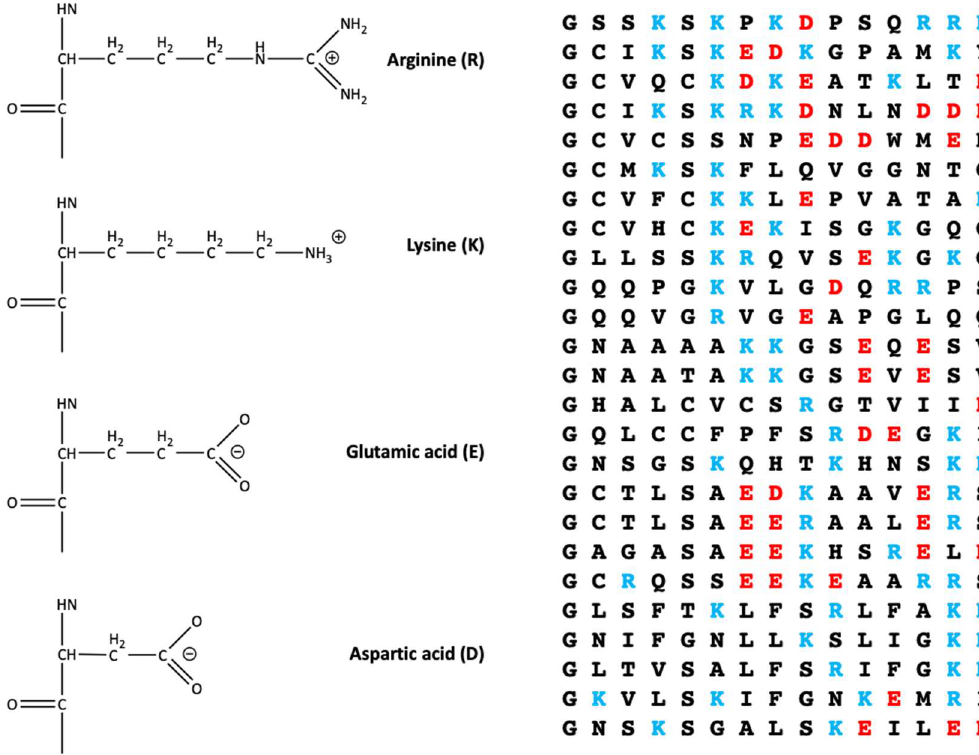
Figure 2. Left. Structure of the charged amino acid residues. Right. Representative sequences of the initial 15 residues (after removal of the initial methionine) of myristoylated proteins listed by Resh et al. [24] with positively and negatively charged residues marked in blue and red, respectively.